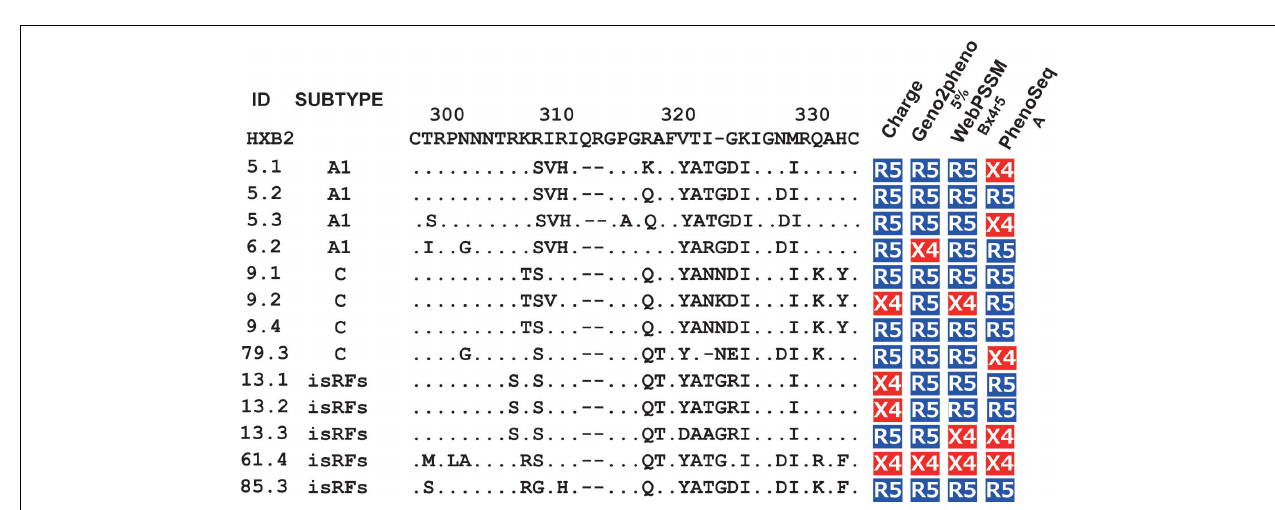
FIGURE 1 | Phenotypic co-receptor tropisms of HIV-1 non-B subtypes isolated in Tanzania. Relative infectivity of lentivirus reporters pseudotyped with control envelopes, NL43 and JRFL (A) and a panel of patient-derived envelope clones (B) are shown. Target cells were U87.CD4 cells expressing either R5 or X4 co-receptor. Data represent the mean of triplicate assays. The background level of luminescence signal was 200 (2.3log) RLU and is represented by the dotted lines.